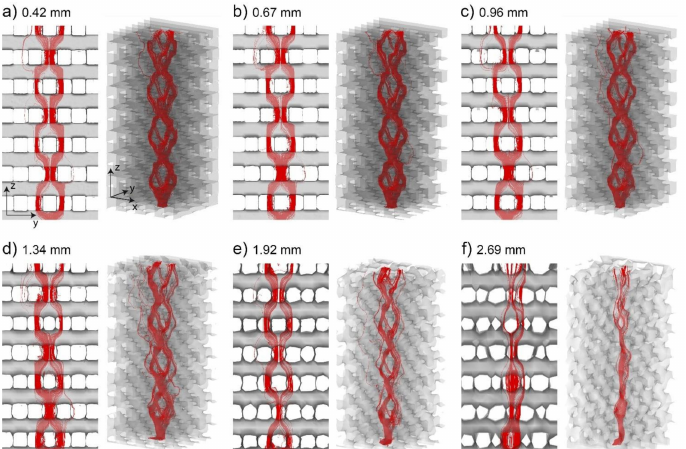
Figure 10. Streamlines calculated from the MRV data for voxel sizes of 0.42 mm ( a ), 0.67 mm ( b ), 0.96 mm ( c ), 1.34 mm ( d ), 1.92 mm ( e ), and 2.69 mm ( f ), each representing a view of the y-z plane ( left panels ) and in an isometric view ( right panels ). The depicted flow geometry represents the fluid boundaries which were reconstructed from the MRV magnitude by applying a